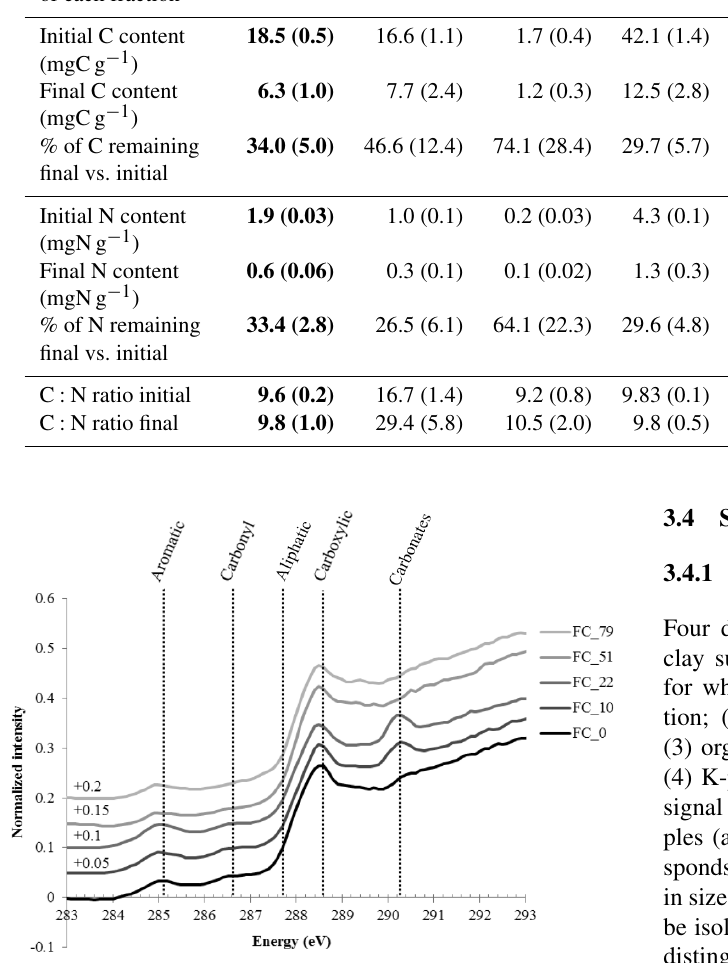
Figure 4. Normalized C-NEXAFS spectra of the fine clay (FC) sub- fraction of samples collected at different times, from t = 0 (bottom spectrum, darkest color) to t = 79 years of bare fallow conditions (upper spectrum, lightest